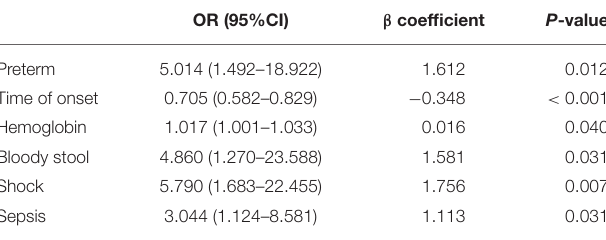
TABLE 5 | Predictors for perforation